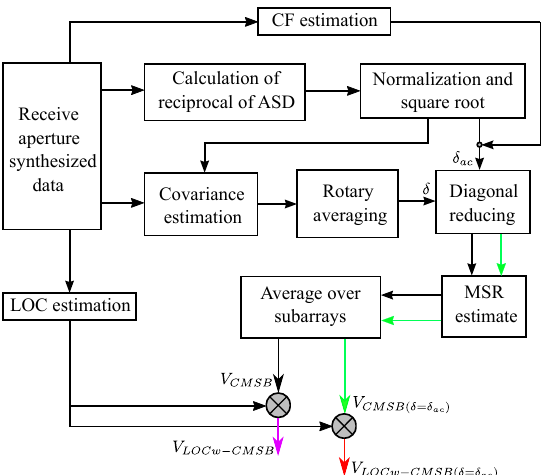
Figure 1. Workflow for CMSB-based beamformers, including CMSB, and the proposed LOCw-CMSB, CMSB ( δ = δ ac ), and LOCw-CMSB ( δ = δ ac ).